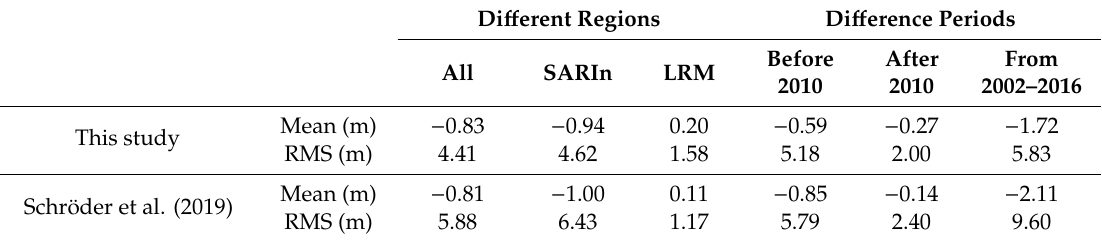
Table 2. Statistics of the comparison between elevation changes derived from the combined elevation time series and those from Operation IceBridge (OIB) observations. The mean and RMS of the di ff erences between elevation changes over the AIS and CryoSat-2 LRM and SARIn mask areas, as well as those acquired before 2010, after 2010, and from 2002 to 2016, are given. Note that the intercomparison results are mainly concentrated along the outlet glaciers of West Antarctica and the Antarctic